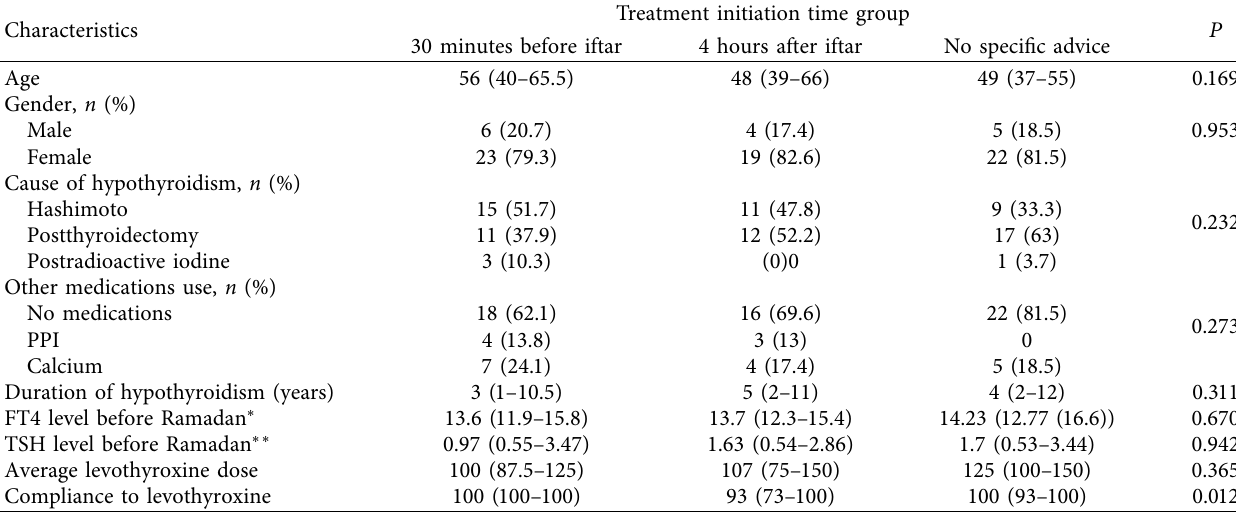
Table 2: Comparison of treatment-related characteristics by the treatment initiation group.